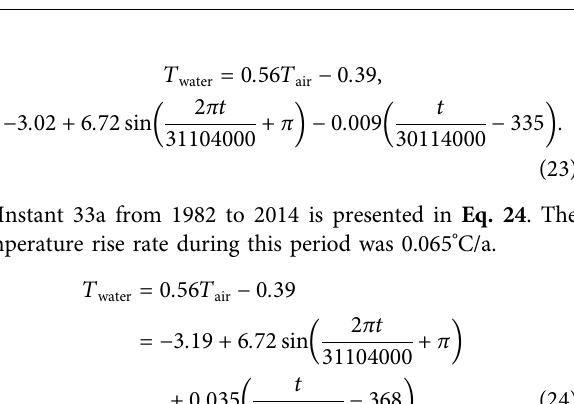
FIGURE 6 | Contrast of water temperature law (1, 4, 7, and 10) in